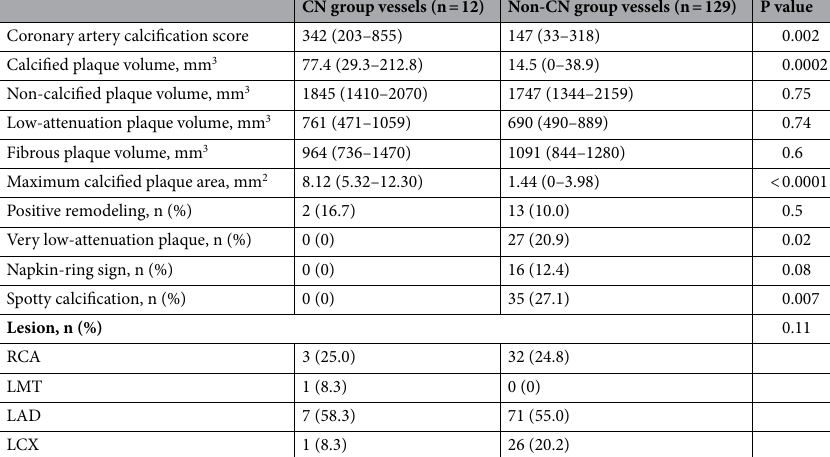
Table 3. CCTA findings at culprit vessel. CACS coronary artery calcification score, CCTA coronary computed tomography angiography, CN calcified nodule, CPV calcified plaque volume, LAPV low-attenuation plaque volume, MCPA maximum calcified plaque area, NCPV non-calcified plaque volume, NPV negative predictive value, PPV positive predictive